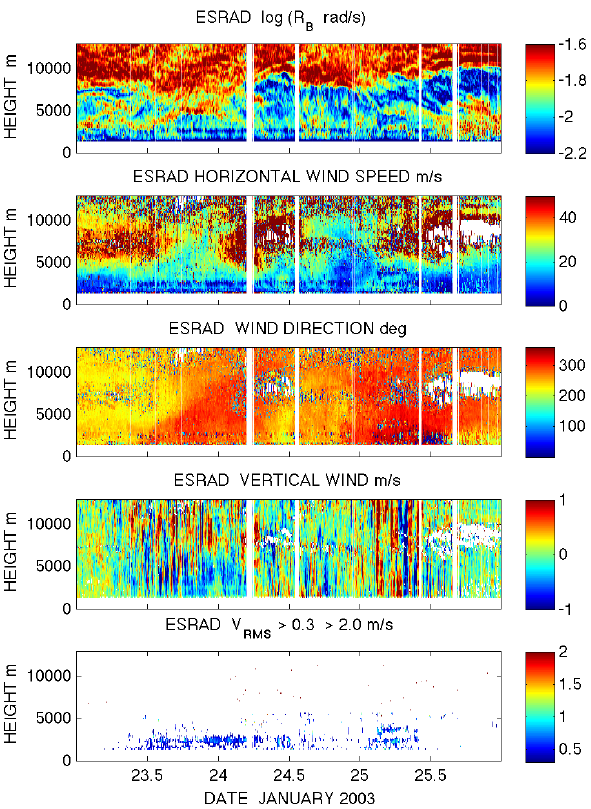
Fig. 5b. Results from the WRF model, for 23, 24 and 25 Jan- uary 2003, innermost nested domain with 1km grid spacing, for the location of the ESRAD radar. Top panel shows the logarithm of the buoyancy frequency, ω B . Next two panels show the speed and direction of the horizontal wind. The direction from which the wind is blowing is given in degrees clockwise from north. The 4th panel shows the vertical wind (positive upwards). The lowest panel shows the bulk Richardson number. See text for further details.